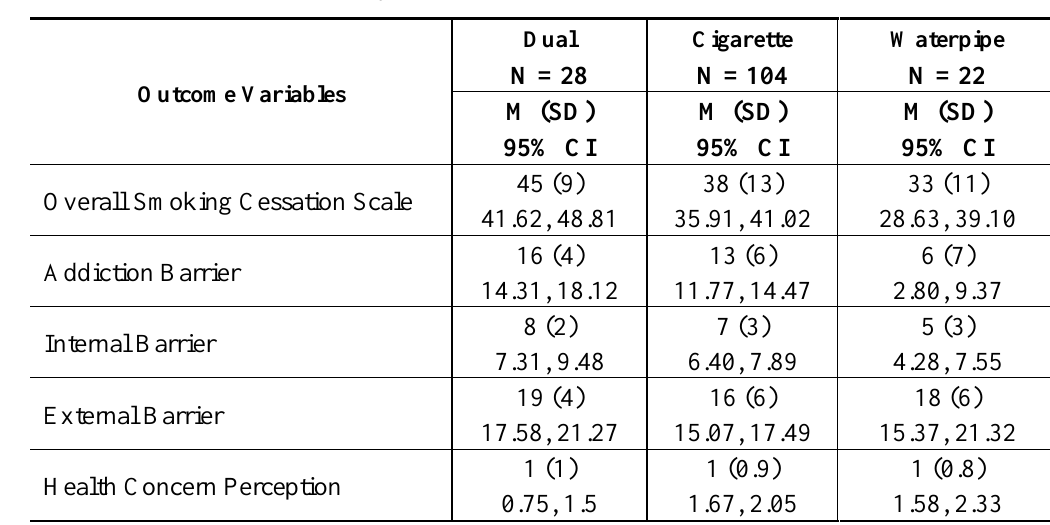
Table 2. Summary of barriers and concern about health